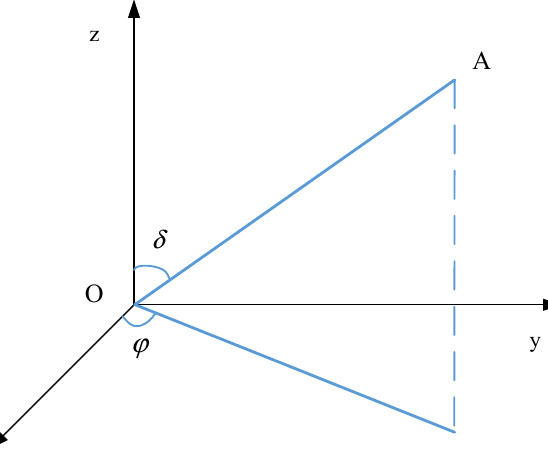
(cid:8) (cid:9) ε x , ε y , ε z , γ xy , γ yz , γ xz ,